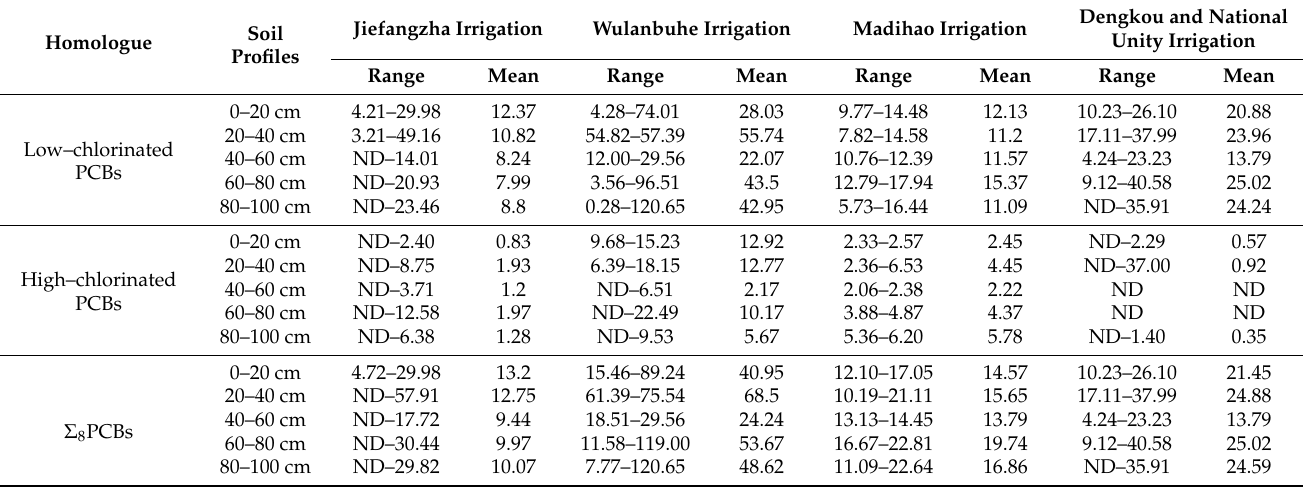
Table 3. Contents of PCBs in different irrigation areas (ng · g − 1